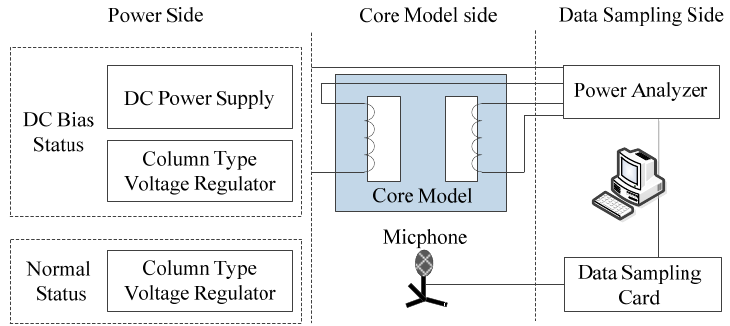
Figure 3. Experiment platform for the core model.